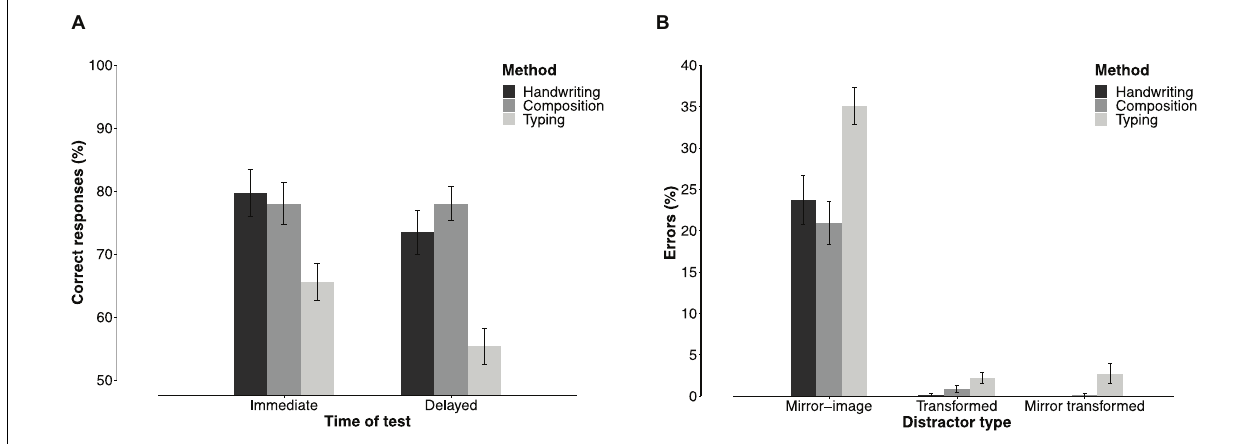
FIGURE 6 | (A) Mean percentage of correct responses for the immediate and delayed 4AFC test across learning methods. (B) Errors produced across the three learning methods. Error bars depict standard